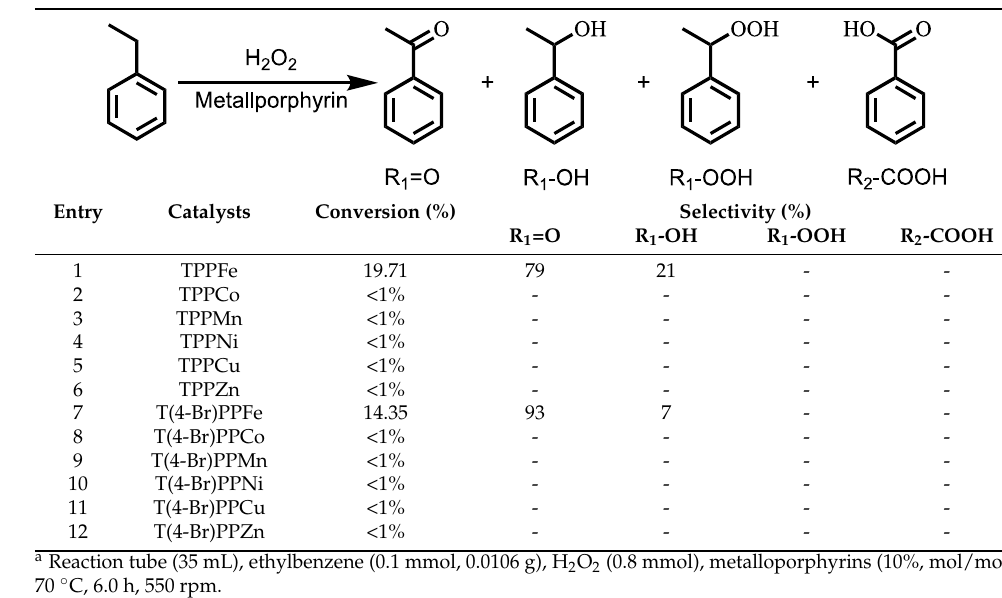
Table 2. Preliminary exploration on the effect of metal centers on alkyl aromatics oxygenation employing ethylbenzene as model substrate a .